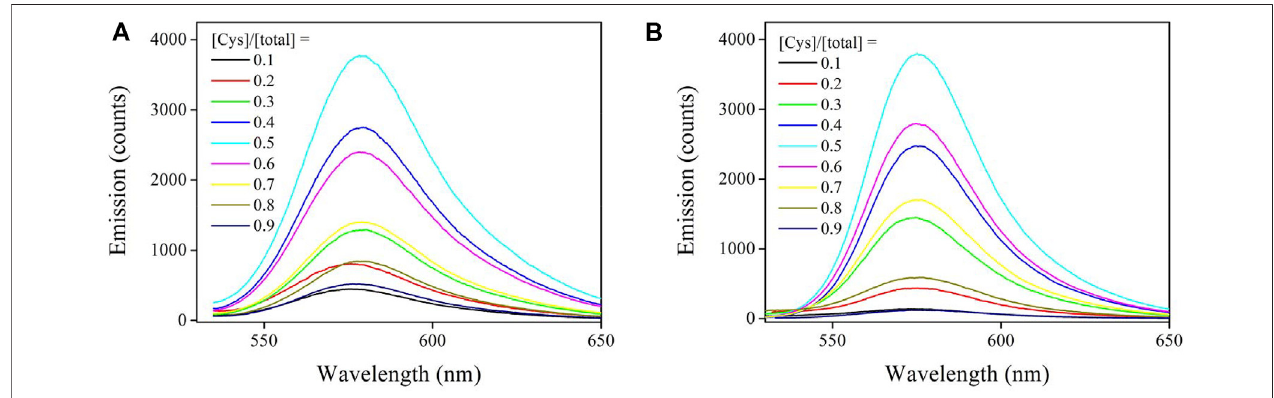
FIGURE 6 | (A) Emission spectra of Sensor-1 and Cys. Their total concentration is fi xed as 10 μ M, then the Cys molar fraction is increased from 0.1 to 0.9. (B) Emission spectra of Sensor-2 and Cys. Their total concentration is fi xed as 10 μ M, then the Cys molar fraction is increased from 0.1 to 0.9.